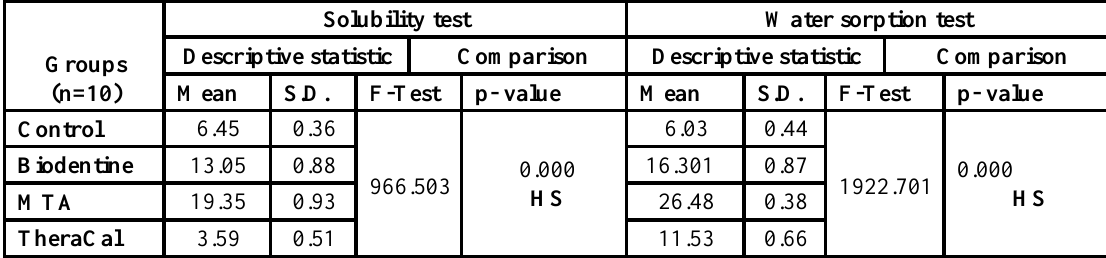
Table (3): Descriptive statistic of Solubility and Water sorption tests, and comparison among the groups using one-way